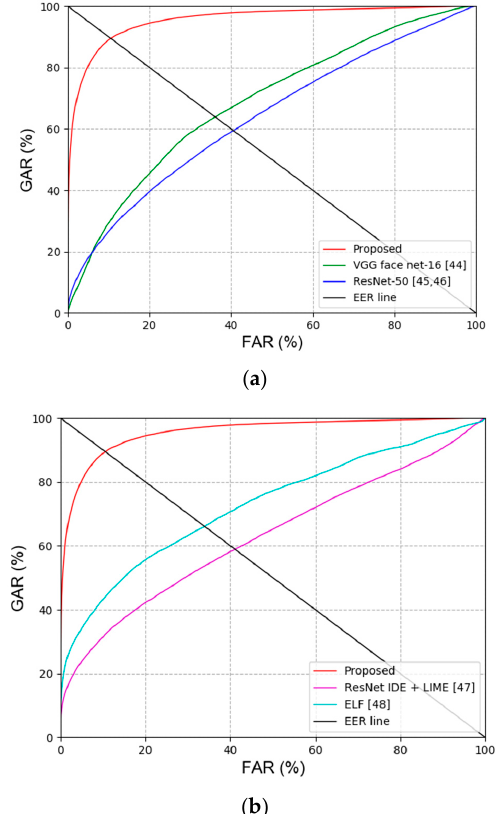
Table 17. Comparisons of EERs obtained using proposed method and state-of-the-art body and face recognition techniques (unit: %).